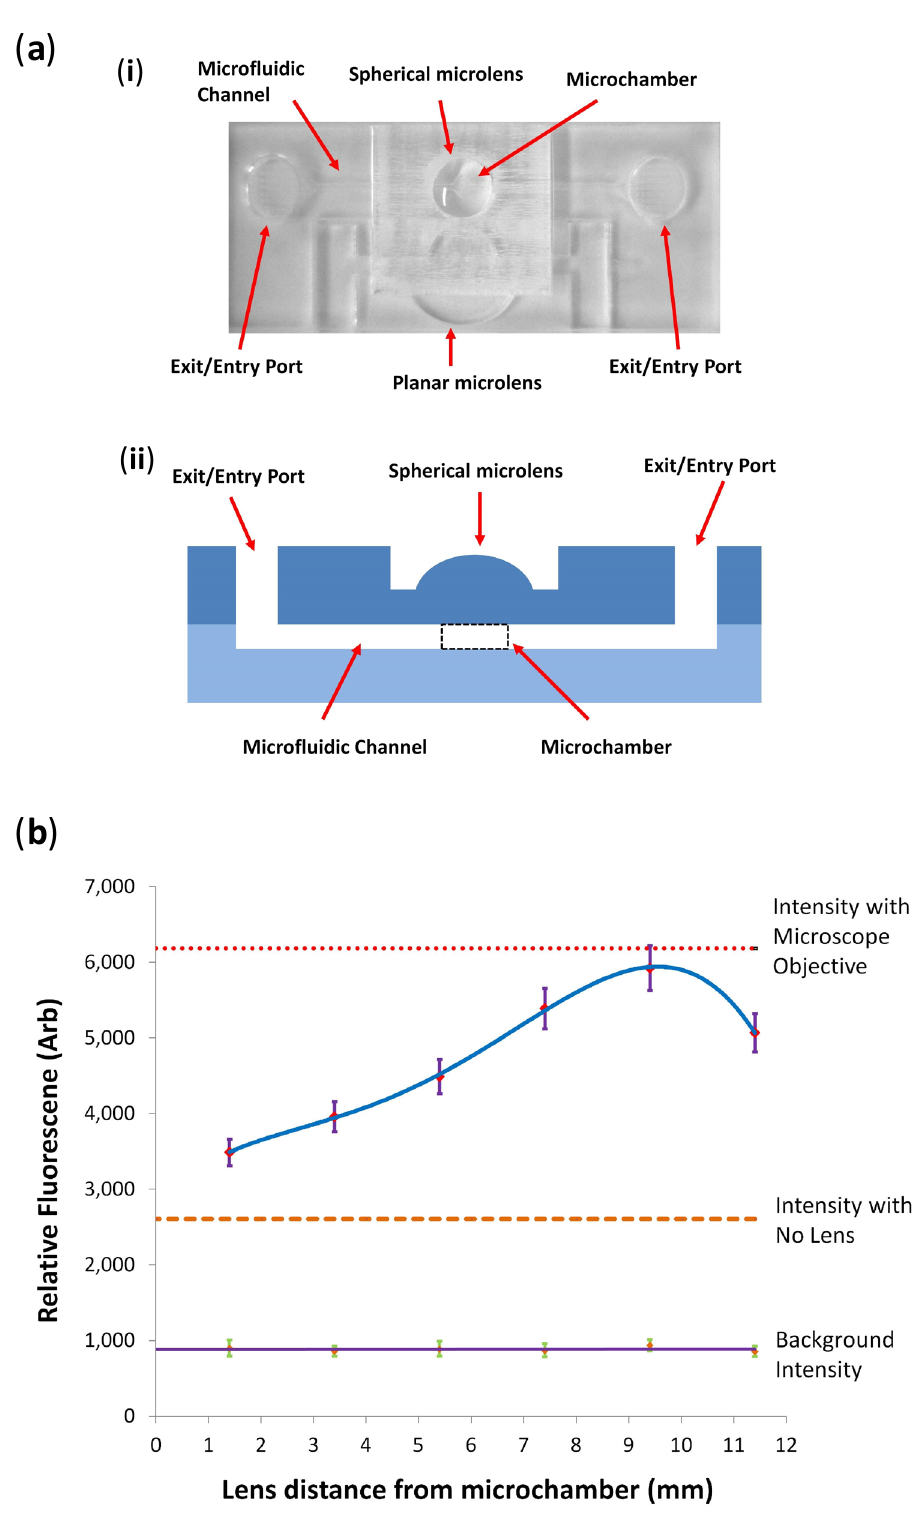
Figure 6. ( a ) ( i ) Photograph of the complete microfluidic chip with integrated planar and spherical lenses and ( ii ) annotated schematic of the microchip cross section; ( b ) Detected fluorescence intensity from a 1-nM sample of FITC within the chip as a function of the distance of the lens from the micro-chamber. As a comparison, results are shown for systems with no spherical lens and additional collection optics; and no spherical lens and a 10× microscope objective for emission